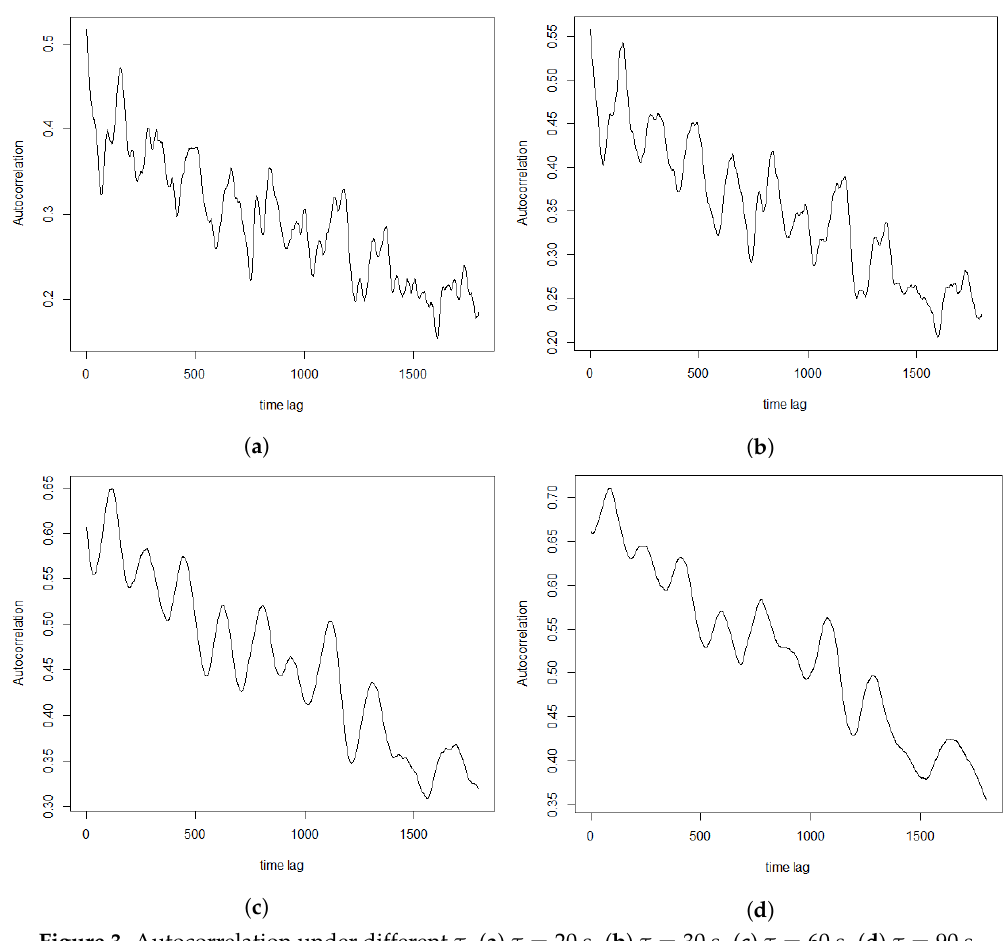
Figure 3. Autocorrelation under different τ . ( a ) τ = 20 s. ( b ) τ = 30 s. ( c ) τ = 60 s. ( d ) τ = 90